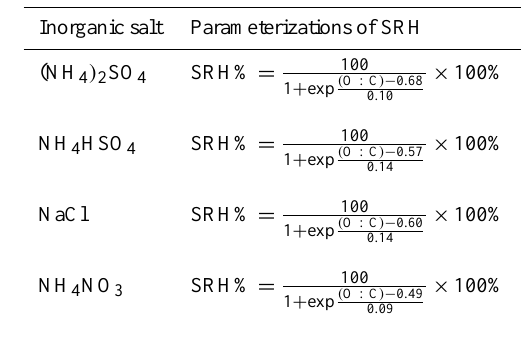
Table 3. Parameterizations of SRH results as a function of the oxygen-to-carbon elemental ratio (O:C) of the organic